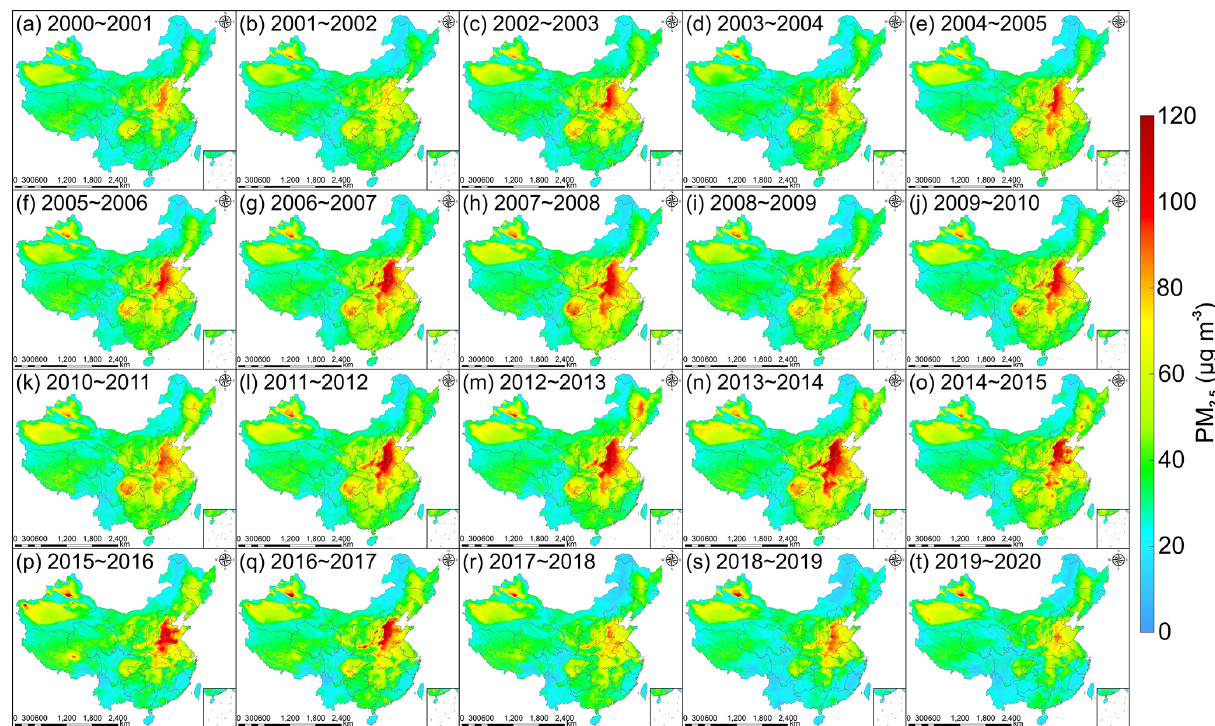
Figure 10. Spatial distribution of mean PM 2 . 5 concentration from LGHAP during the winter half year (September–February) from 2000 to 2020 in China.